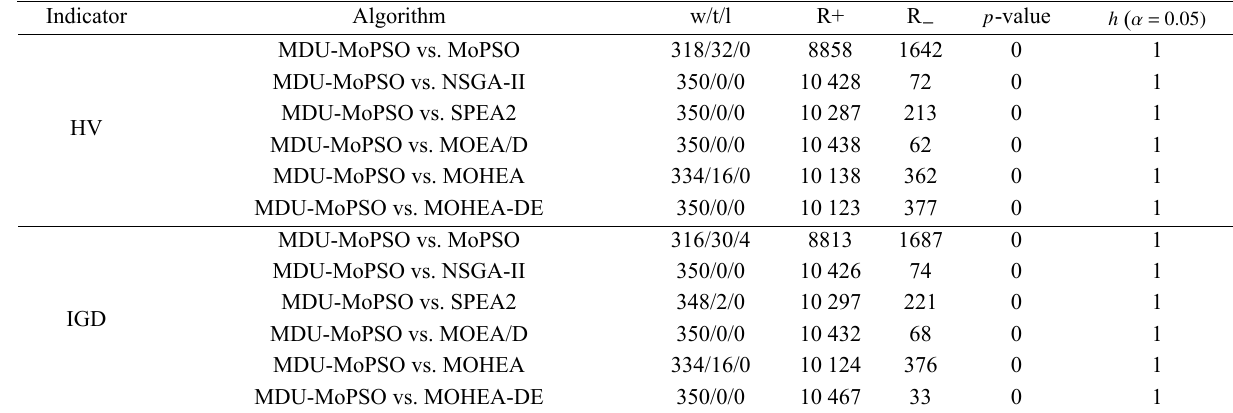
Table 9 Significance analysis result obtained by the Wilcoxon rank sum test.